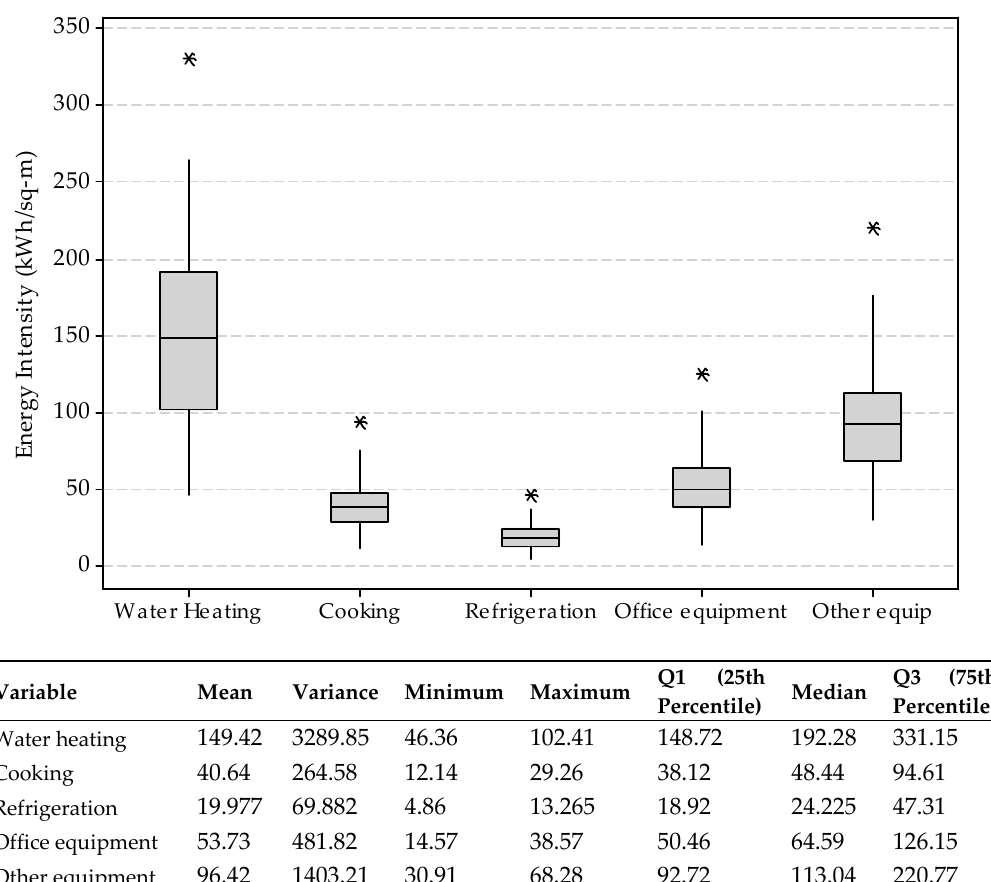
Figure 7. Healthcare facilities’ annual process energy intensity.